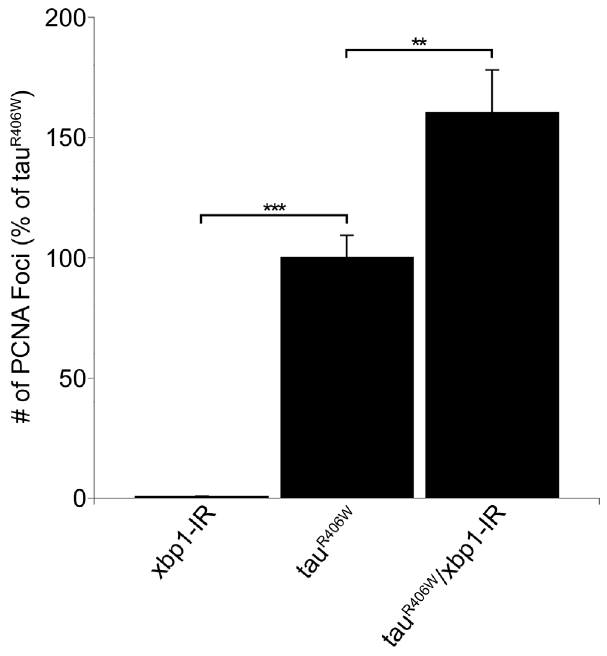
Figure 5. Increased cell cycle activation in flies with reduced levels of Xbp1. PCNA in tau transgenic flies expressing RNAi to Xpb1 (Xbp1-IR) using the panneural elav-GAL4 driver. **P , 0.01, *** P , 0.001, one-way ANOVA with Tukey test for multiple comparisons. Flies are 10 days old.